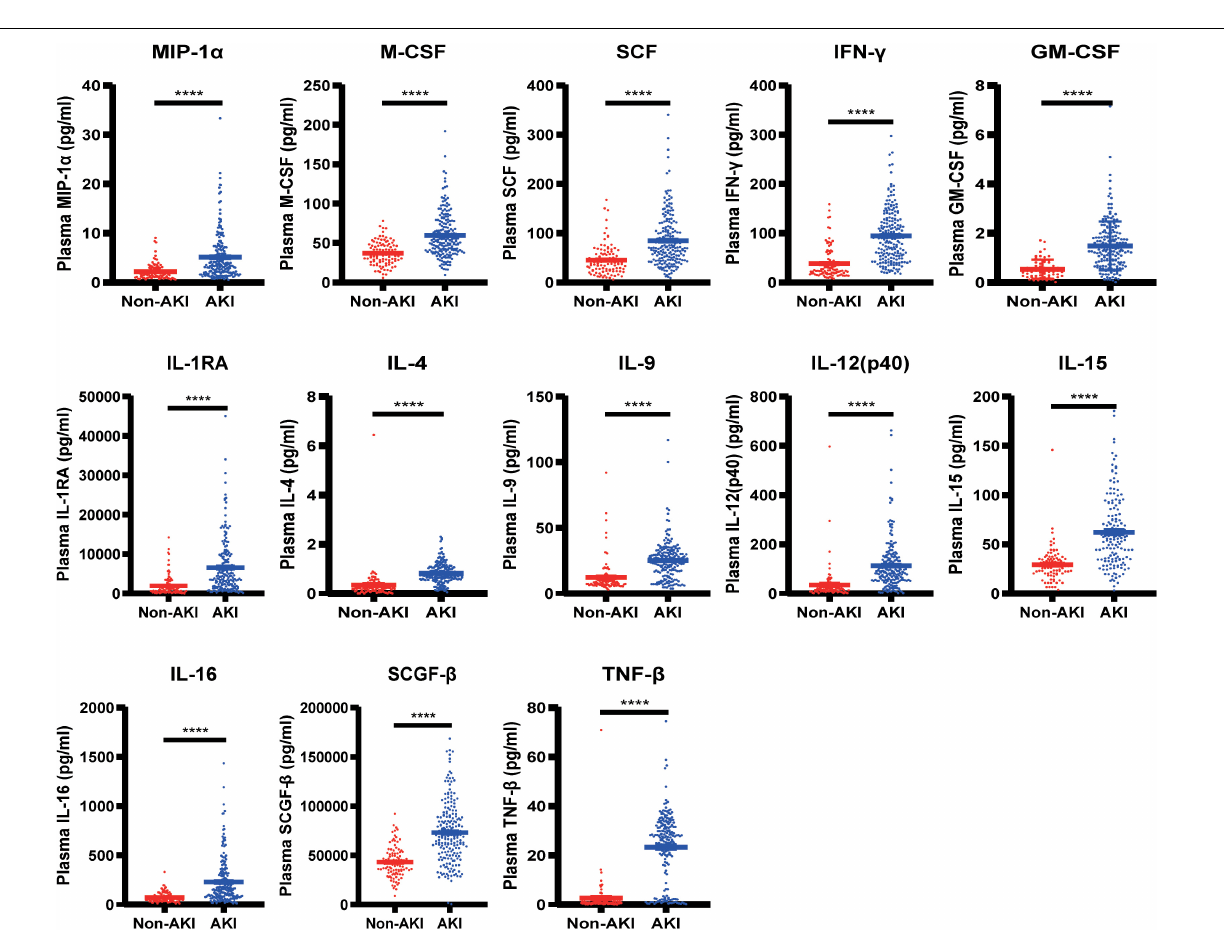
Frontiers in Physiology | www.frontiersin.org